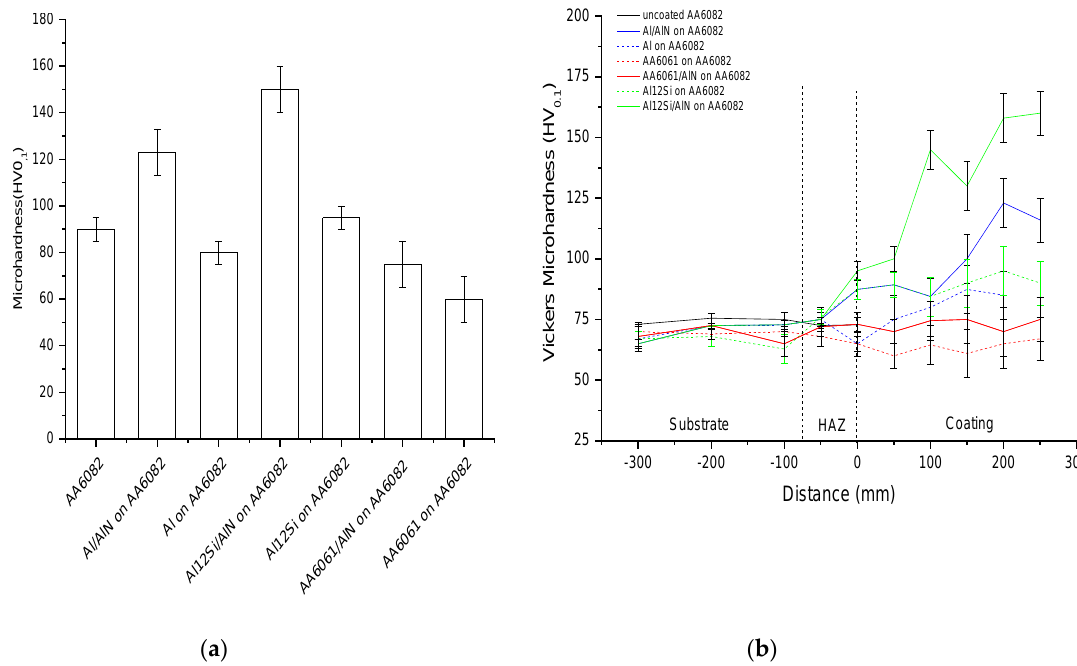
Figure 7. ( a ) Coatings and substrate average Vickers microhardness (HV 0.1 ); ( b ) Vickers microhardness (HV 0.1 ) evolution along the coatings and the substrate.